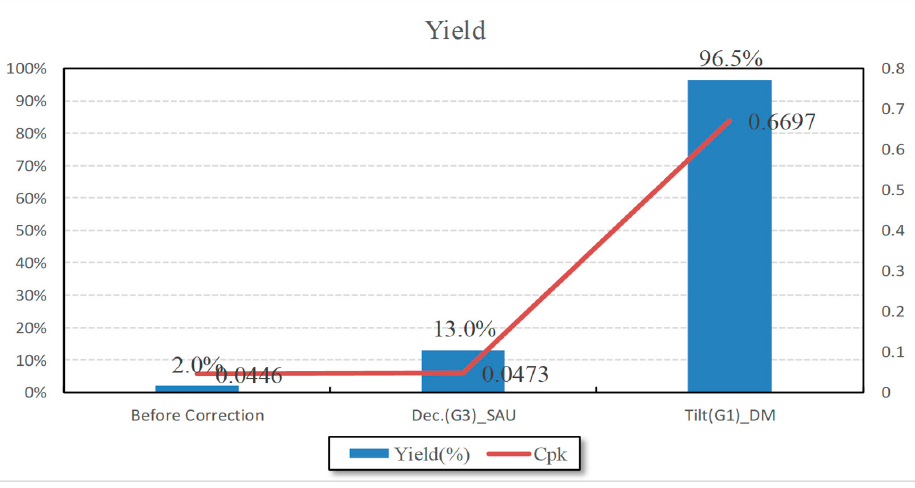
Figure 15. The process capability index for the designed and assembled optical system.